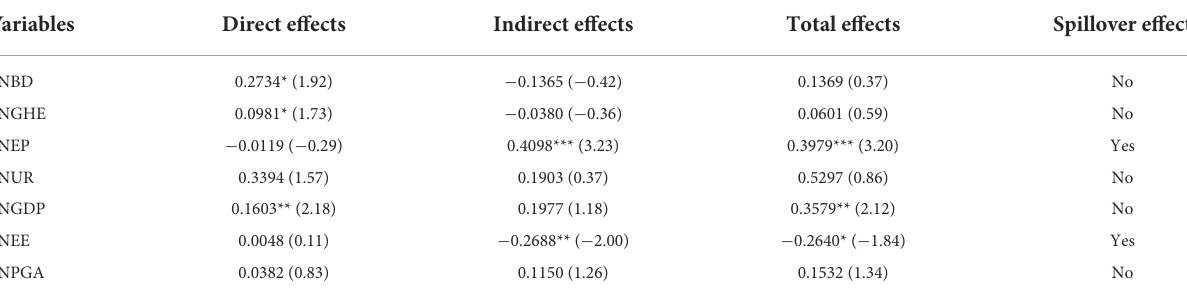
TABLE 6 Direct, indirect, and total effects of independent variables on